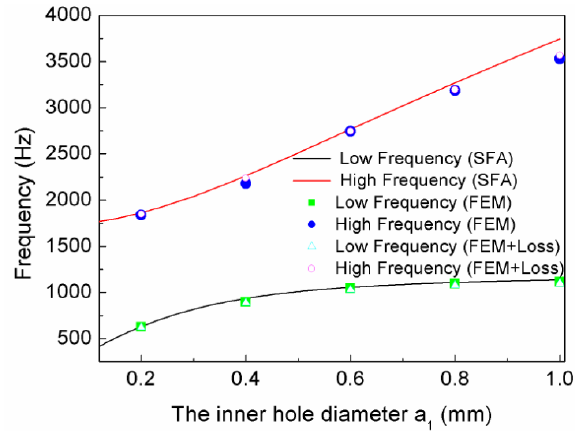
Figure 5. The relationship curves of the inner hole diameter and resonant frequencies.